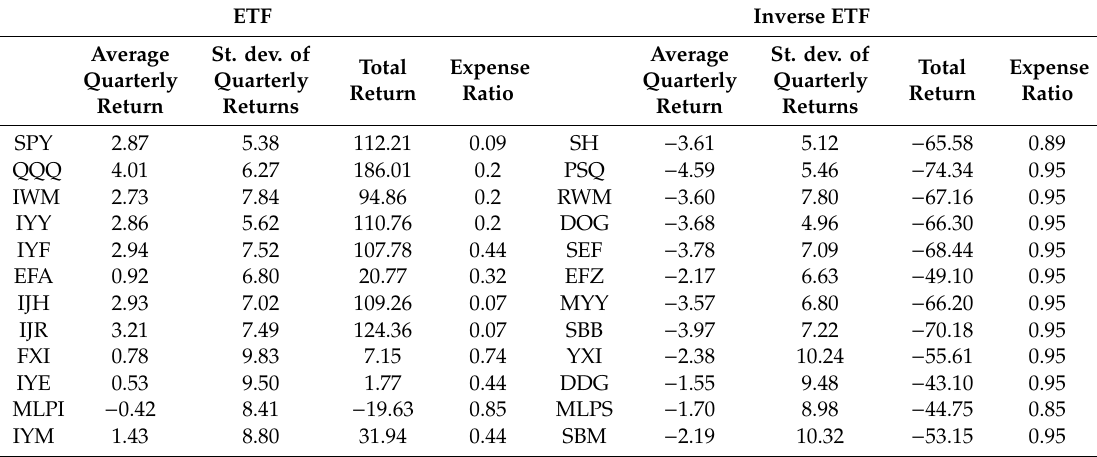
Table 1. Comparison of ETFs and 1 X inverse ETFs with the same benchmark index for the period 2011–2017 (in